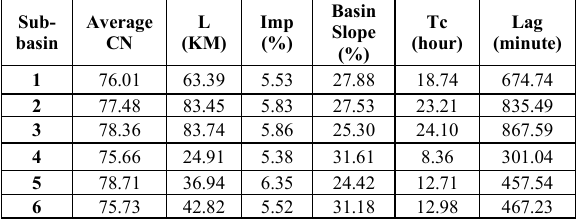
Table 2. Catchment characteristics for Sungai Lebir Basin Sub- basin